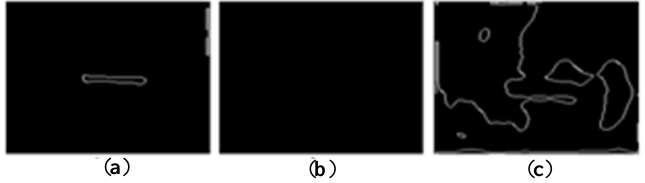
Figure 24. Notch edge detection, obtained with ( a ) the developed fuzzy c-mean thresholding algorithm, ( b ) the traditional fuzzy c-mean thresholding algorithm, and ( c ) Otsu’s thresholding algorithm.